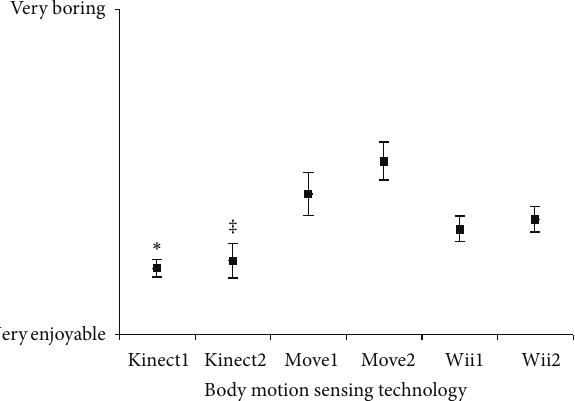
Figure 6: Rating of perceived game enjoyment reported immedi- ately after performing each of the different dance routines using the various different body motion sensing technologies. Data are shown as mean ( 𝑛 = 11 ) and error bars indicate SEM. ∗ indicates significantly more enjoyable versus Move1, Move2 and Wii2 ( 𝑃 < 0.05 ). ‡ indicates significantly more enjoyable versus Move2 ( 𝑃 < 0.05 ).